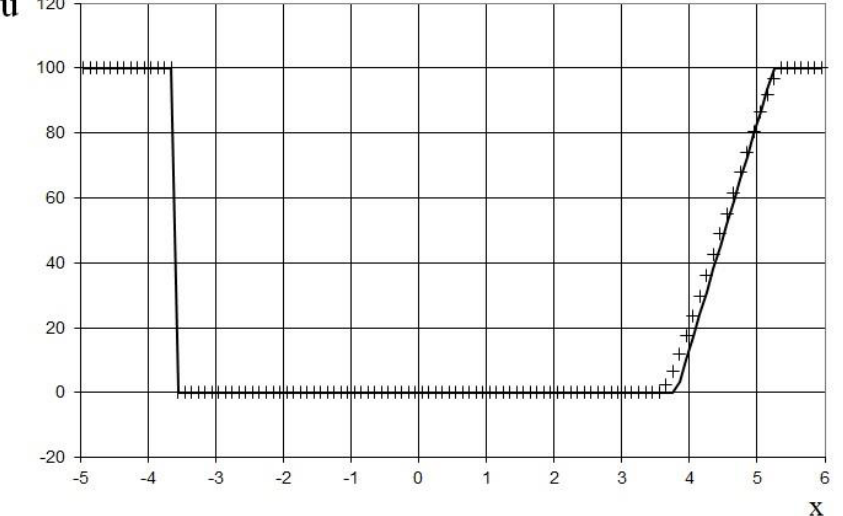
Figure 26. Density plot for the problem (53): the exact solution (line), and the present method (cross).